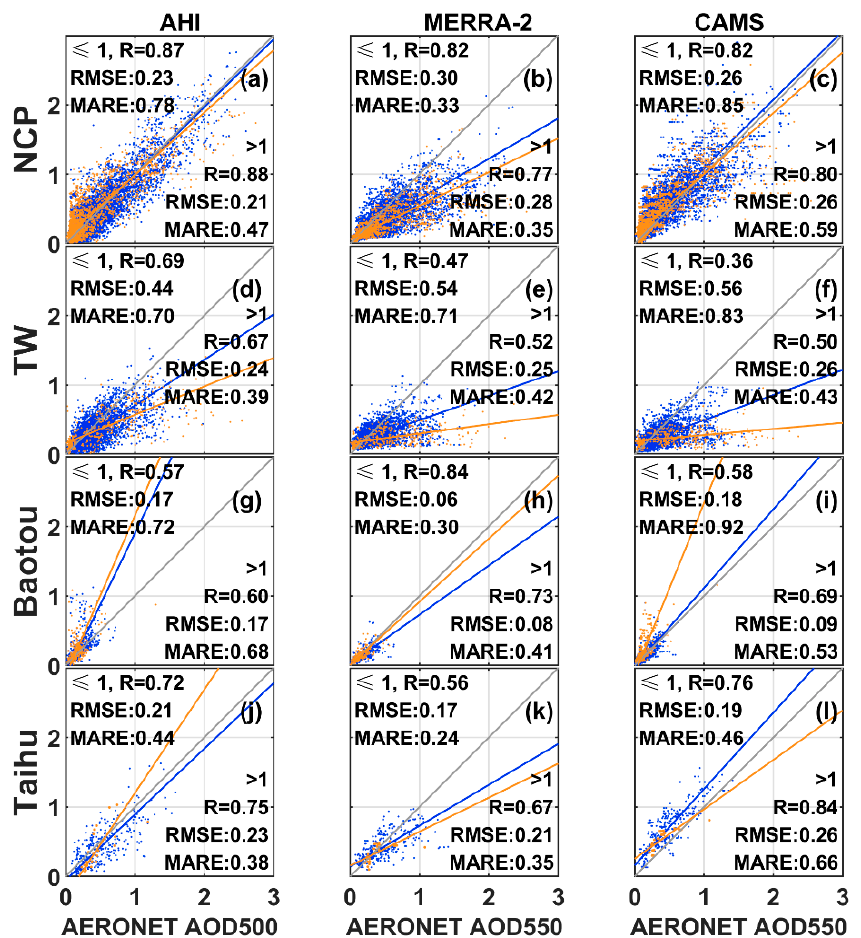
Figure 6. Scatterplots of AHI, MERRA-2, and CAMS AOD versus AERONET AOD in NCP, HK, and TW when AE > 1 (in orange) and ≤ 1 (in blue), respectively ( a – l ). The y-axis of columns 1–3 indicates AODs from AHI, MERRA-2, and CAMS, respectively.